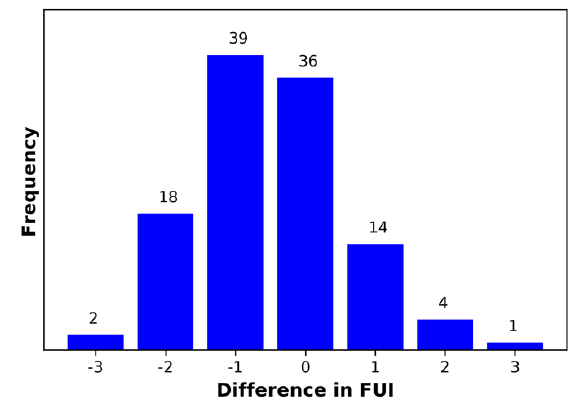
Figure 8. Frequency distribution of the difference in Forel–Ule index (FUI) between the WACODI- processed value (P) and the FUI entered by the observer (O).